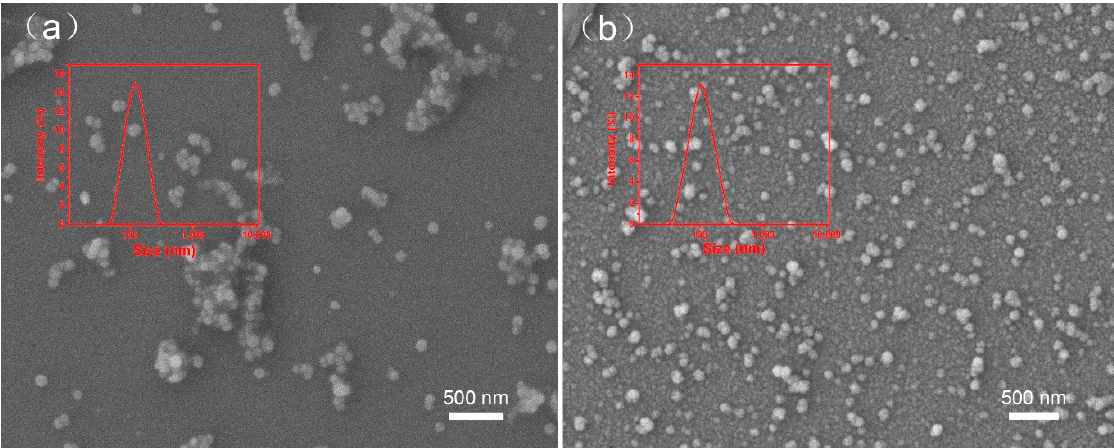
Figure 8. The DLS and SEM characterization of different drug nanoparticles. ( a ) Avermectin, ( b ) pyraclostrobin.